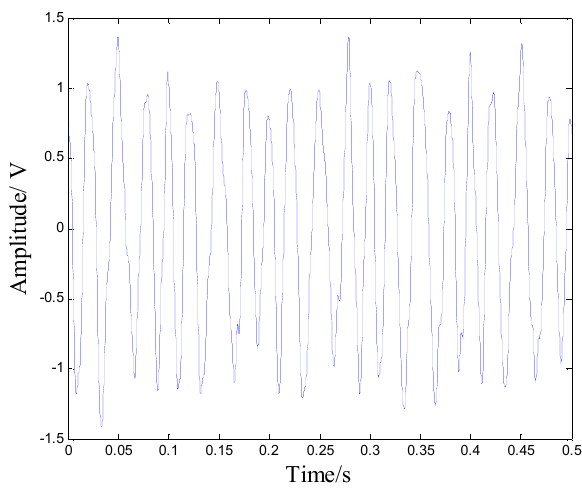
Figure 17. Time domain plot of denoised FM signal with noises.